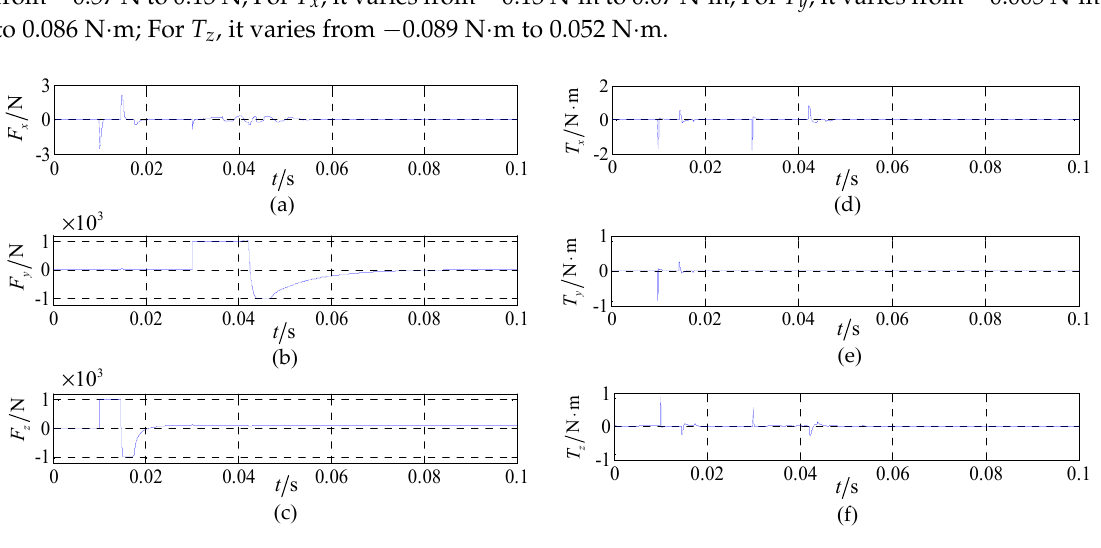
Figure 11. Force and torque curve of the control system based on the analytical method.